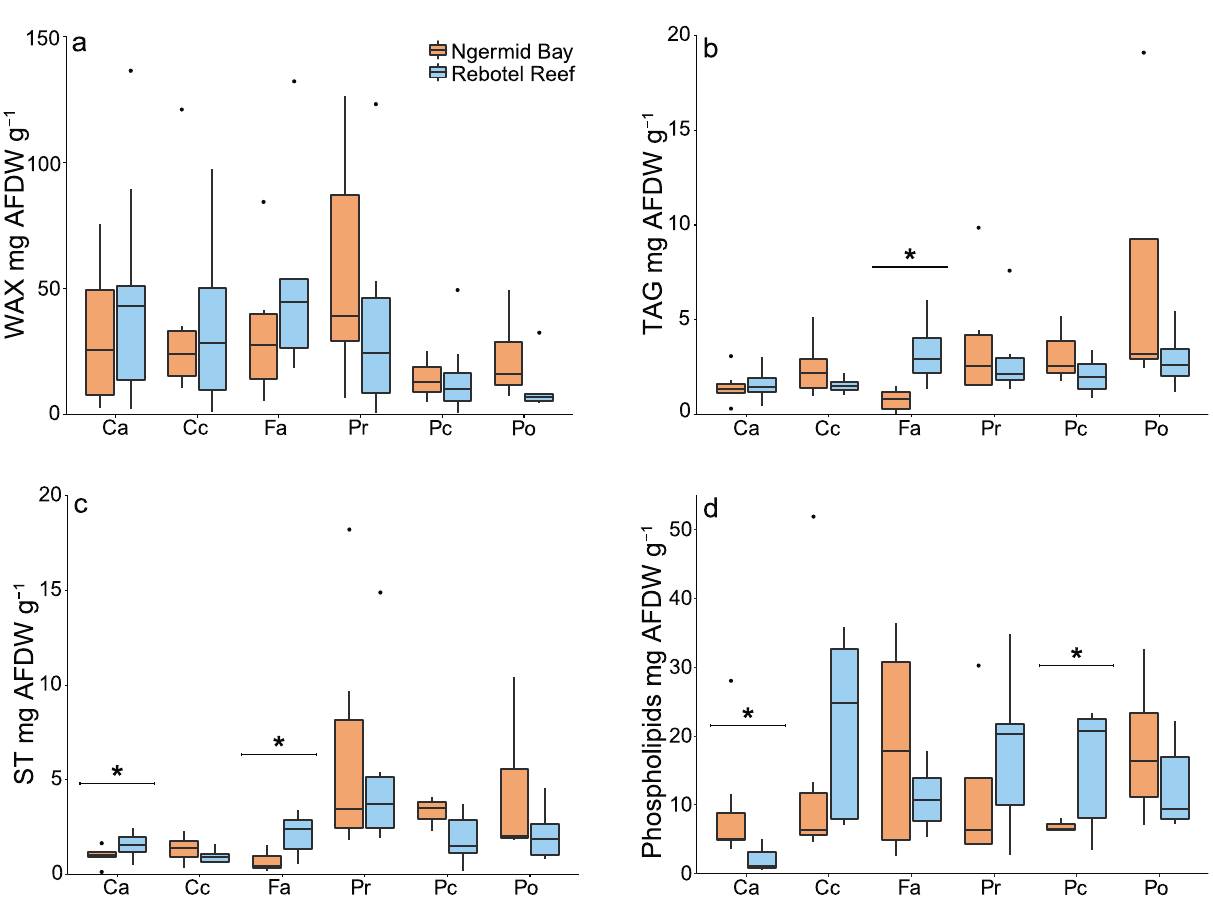
Figure 3. Composition of ( a ) wax esters (WAX), ( b ) triacylglycerols (TAG), ( c ) sterols (ST) and ( d ) phospholipids in mg relative to ash-free dry weight (AFDW) from six coral species from nearshore (Ngermid Bay; orange) and offshore (Rebotel Reef; blue). Abbreviations for coral species are as follows: Ca, Coelastrea aspera ; Cc, Cyphastrea chalcidicum ; Fa, Favites abdita ; Pr, Pachyseries rugosa ; Pc, Porites cylindrica , and Po, Porites rus . Tukey boxplots depict median, first and third quartile, and whiskers extend no more than 1.5 × the interquartile range, with outliers plotted individually. Intraspecific significance is denoted with a bracket and